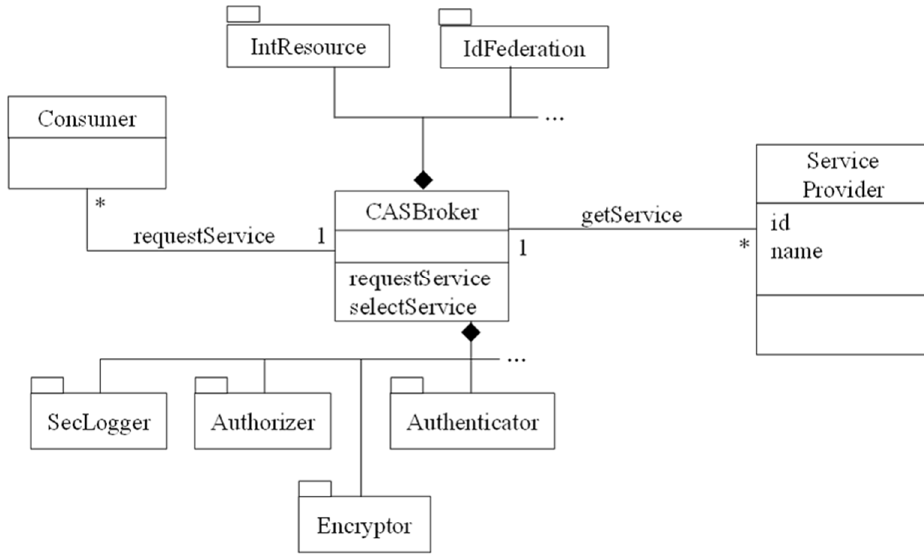
Figure 3. Class diagram of the CASB pattern.